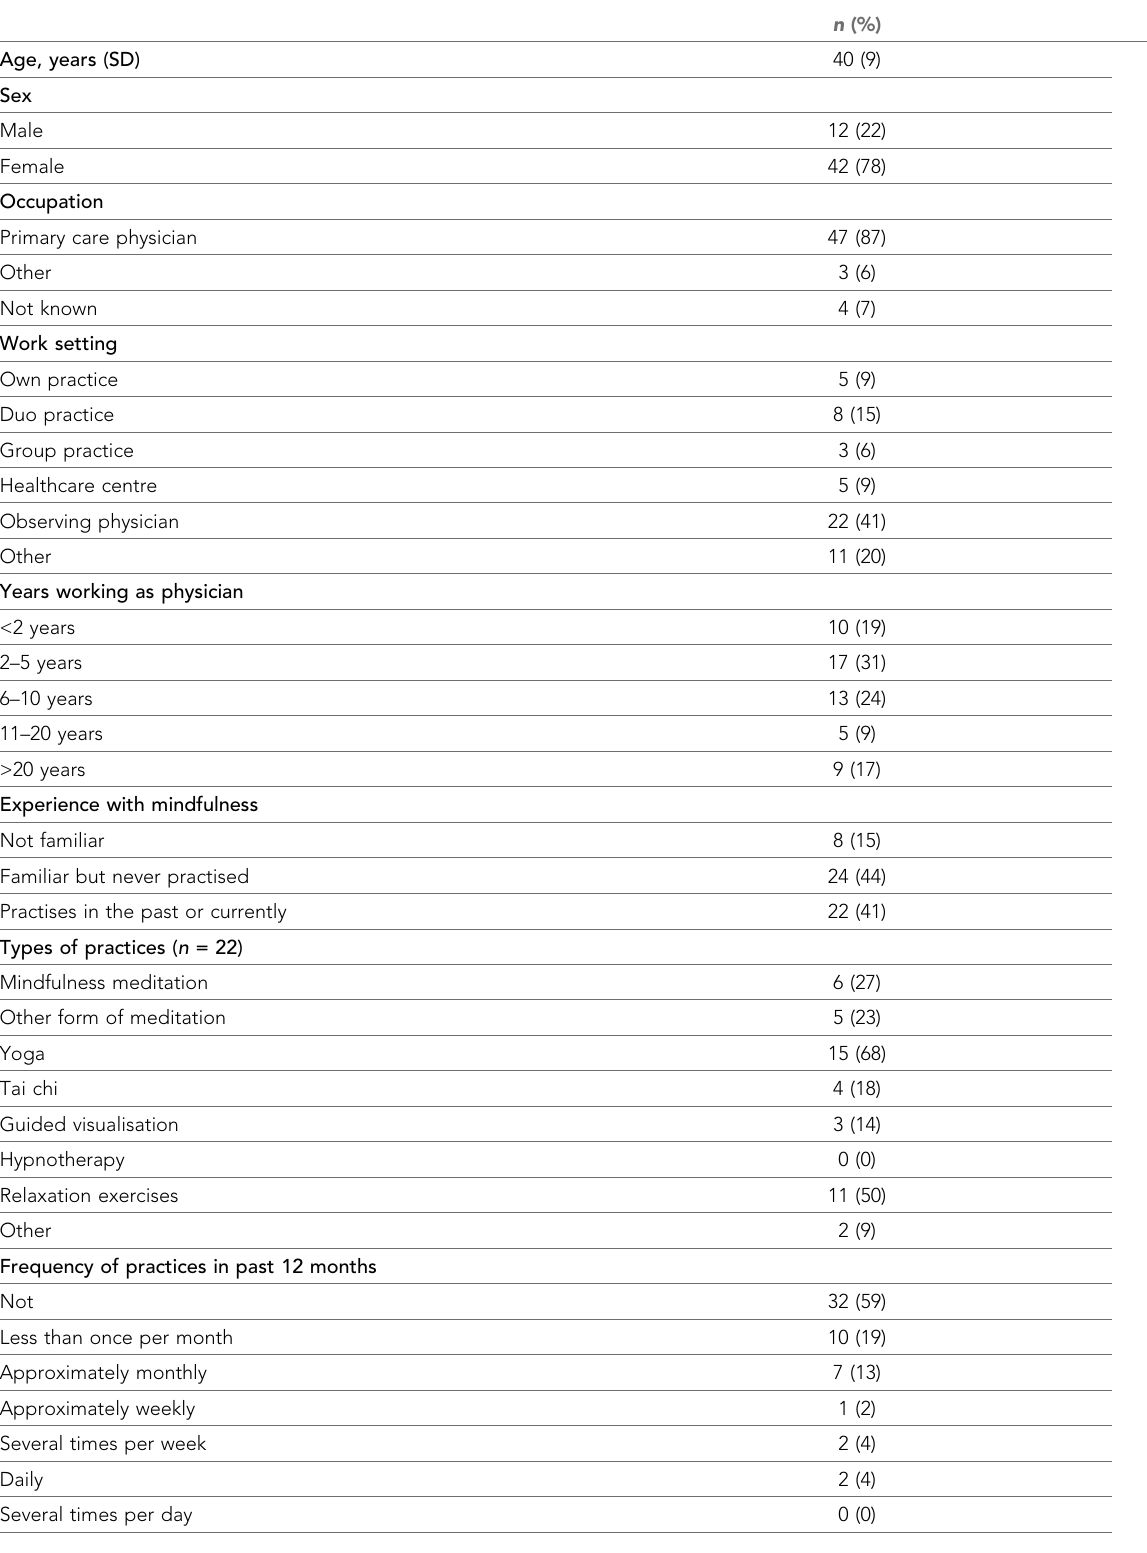
Table 1. Demographic characteristics of participants ( n =